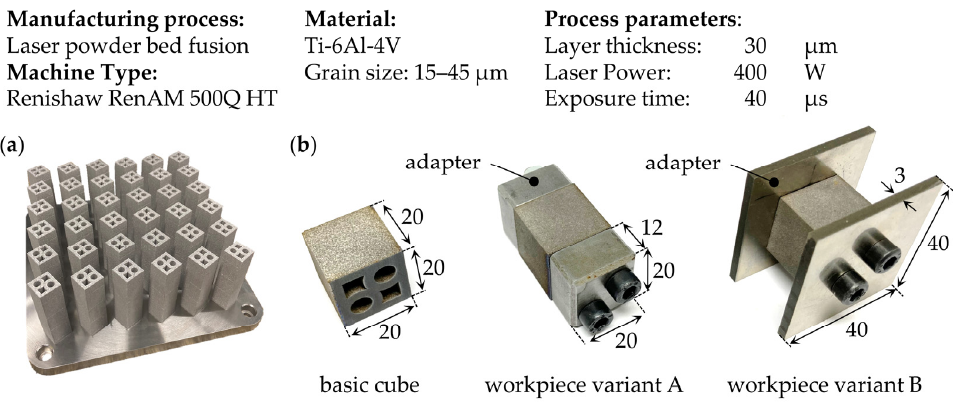
Figure 4. Workpieces of finishing experiments: ( a ) as built; ( b ) eroded basic cube and workpiece variants.